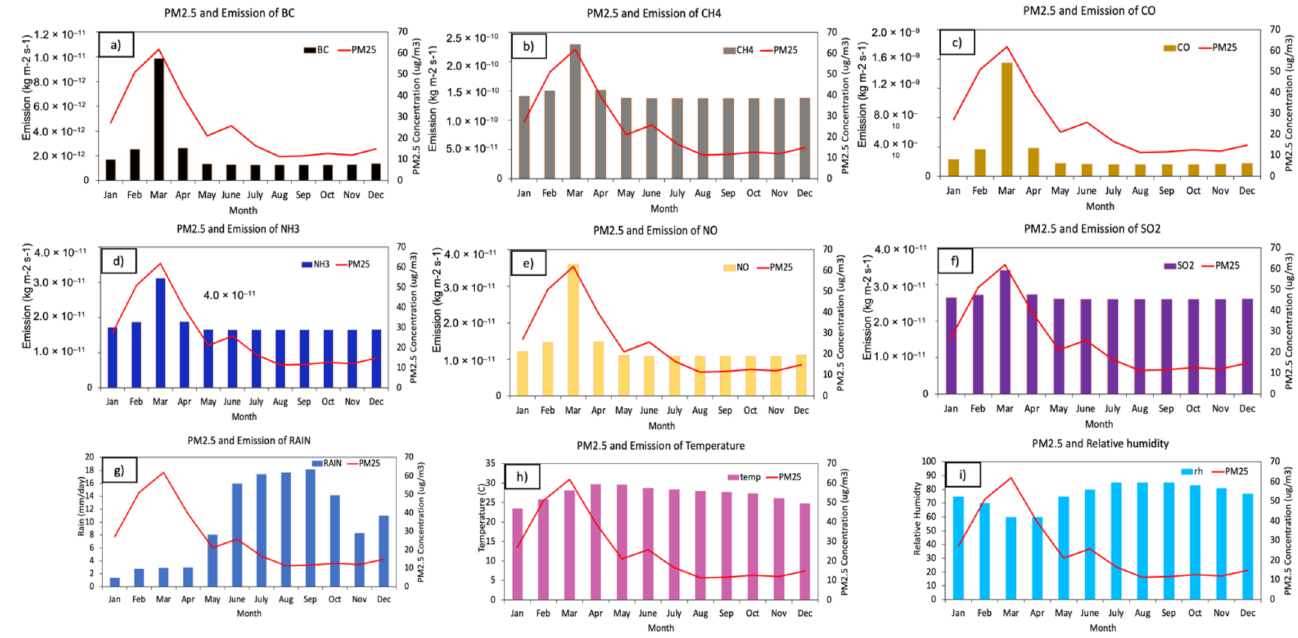
Figure 7. The plot of relationship between PM 2.5 and ( a ) emission of BC, ( b ) emission of CH4, ( c ) emis- sion of CO, ( d ) emission of NH 3 , ( e ) emission of NO, ( f ) emission of SO 2 , ( g ) RAIN, ( h ) temperature, and ( i ) Relative Humidity over the northern Thailand in